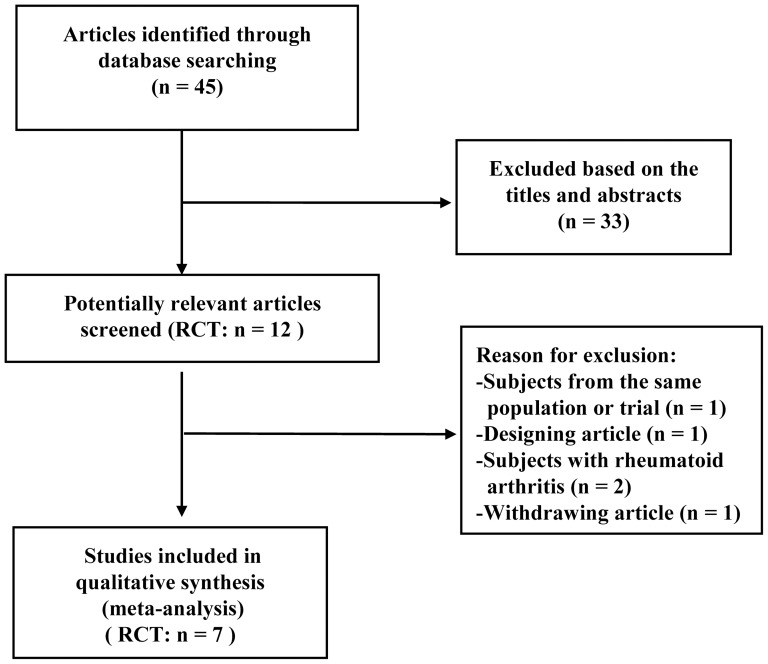
Search strategy and flow chart for this meta-analysis.RCT: randomized controlled trial.